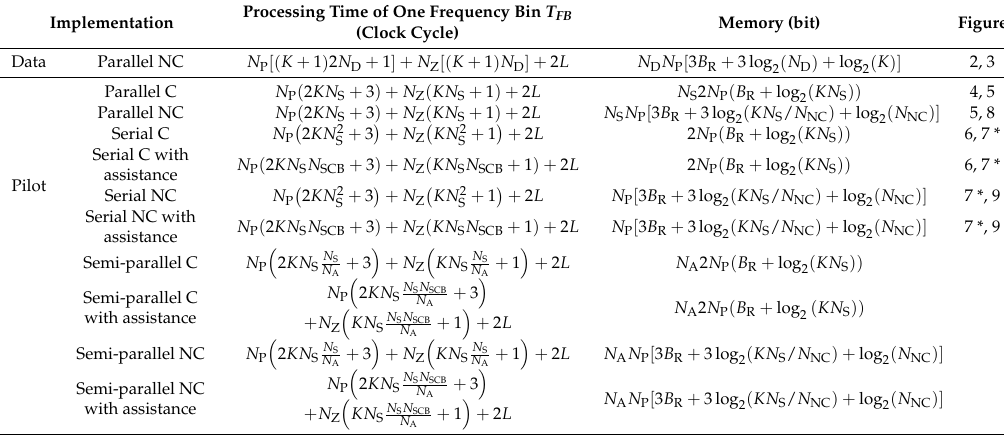
Table 2. Summary of the processing time and memory requirements of the different implementations.